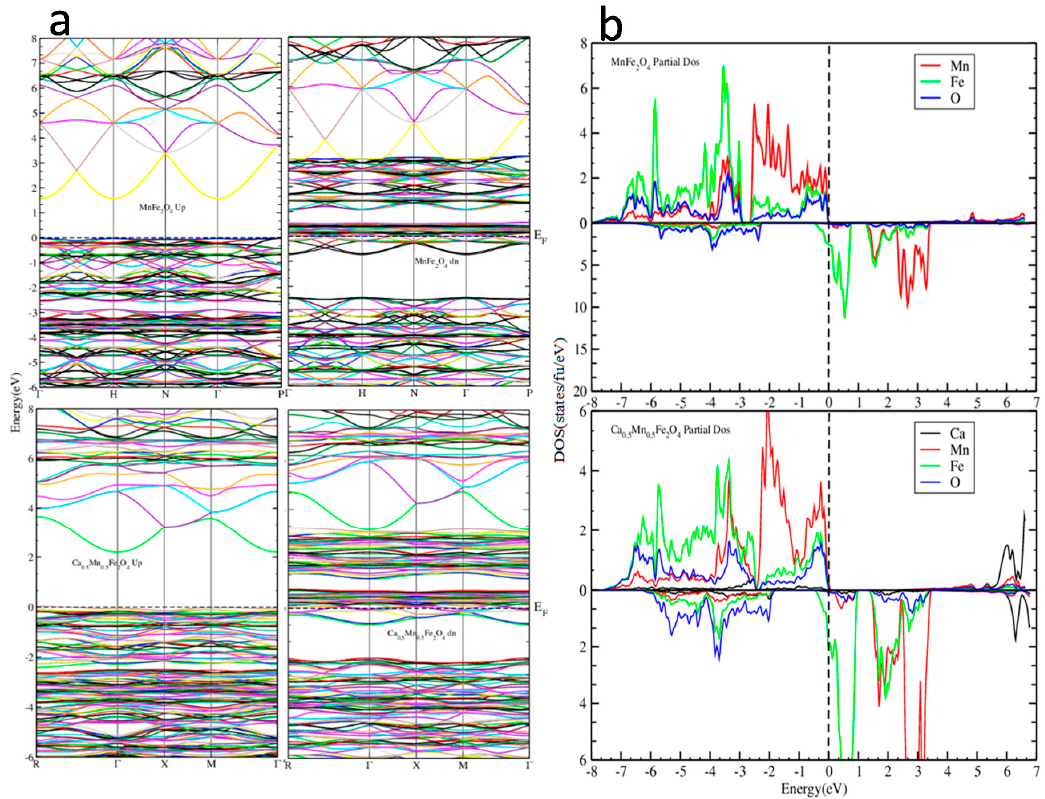
Figure 4. ( a ) Calculated spin-polarized band, ( b ) partial contribution of different atoms in the electronic structure of MnFe 2 O 4 and Ca 0.5 Mn 0.5 Fe 2 O 4 .